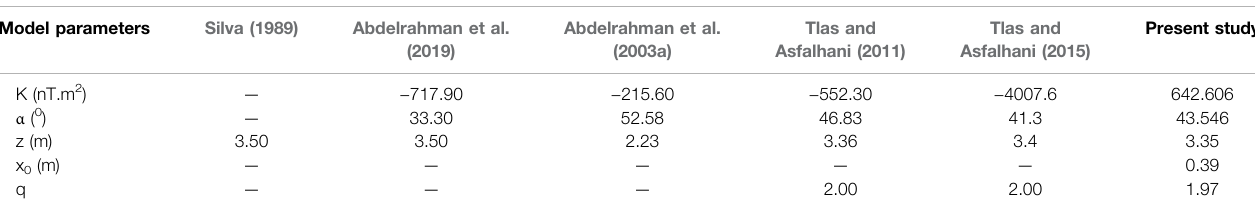
TABLE 9 | Comparative analysis of parameter results for the Parnaiba anomaly. Model